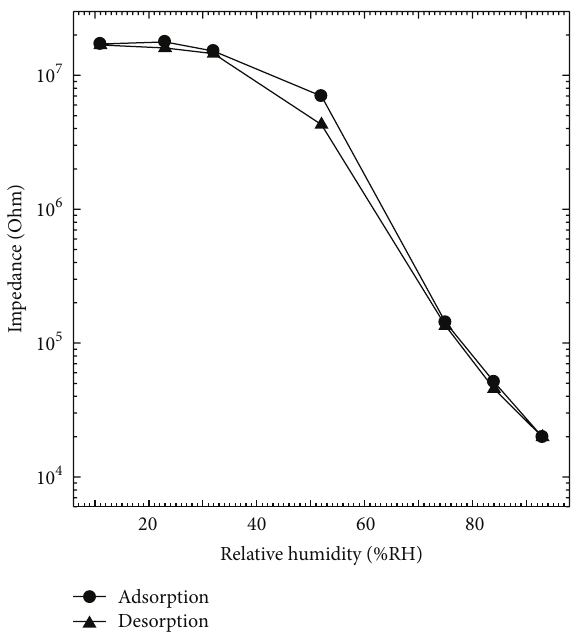
Figure 7: Hysteresis characteristics of the Ag NPs humidity sensor at deposition time of 5 min.